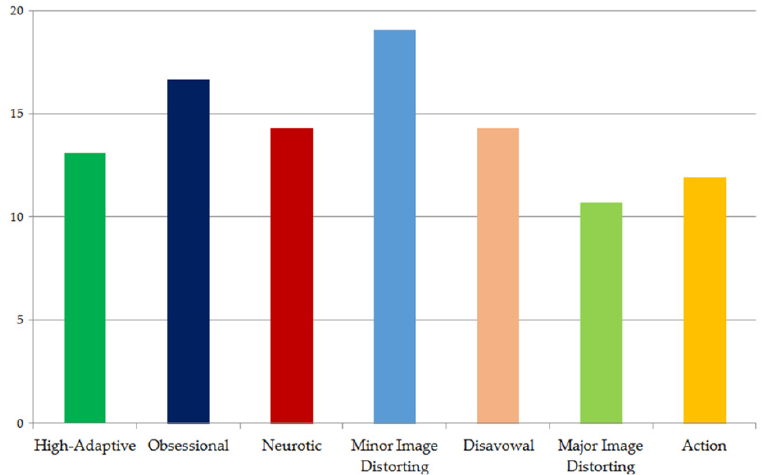
Figure 2. The defensive profile empirically derived from the DMRS-Q shows that Albert mostly uses the minor image-distorting defenses.